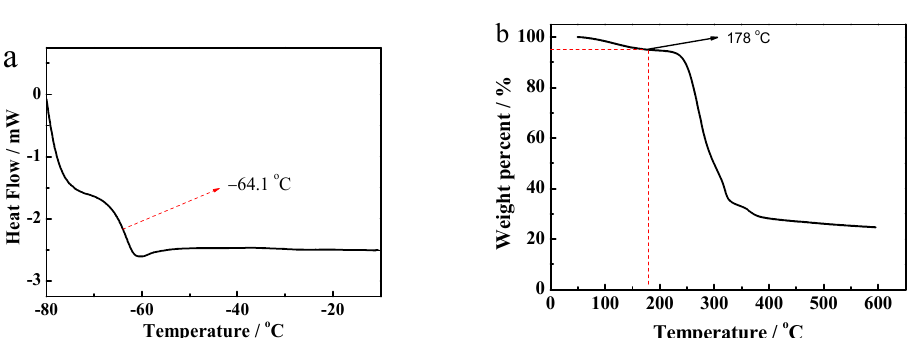
Figure 1. 1 H-NMR spectrum of TLP in D 2 O.